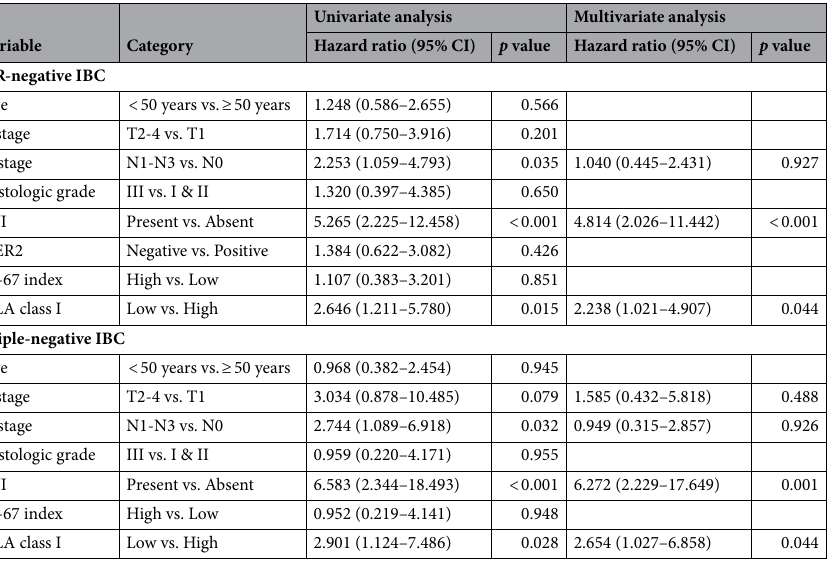
Table 6. Univariate and multivariate analyses of disease-free survival in the HR-negative and triple-negative IBC. HR hormone receptor; IBC invasive breast carcinoma, CI confidence interval, LVI lymphovascular